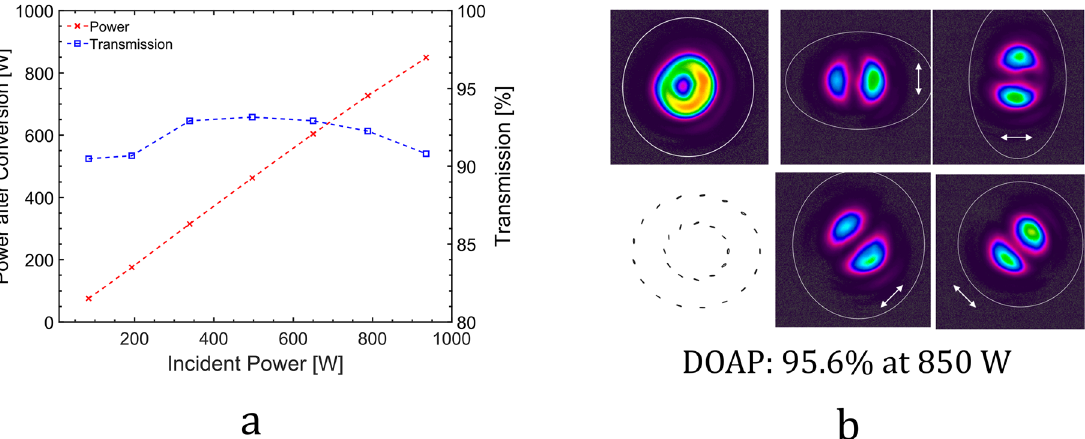
Figure 15: Experimental results obtained with the segmented polarizaton converter (SPC) with (a) Measured power transmission through the polarization converter and cleanup; (b) recorded intensity distribution of the converted azimuthally polarized beam without and with a